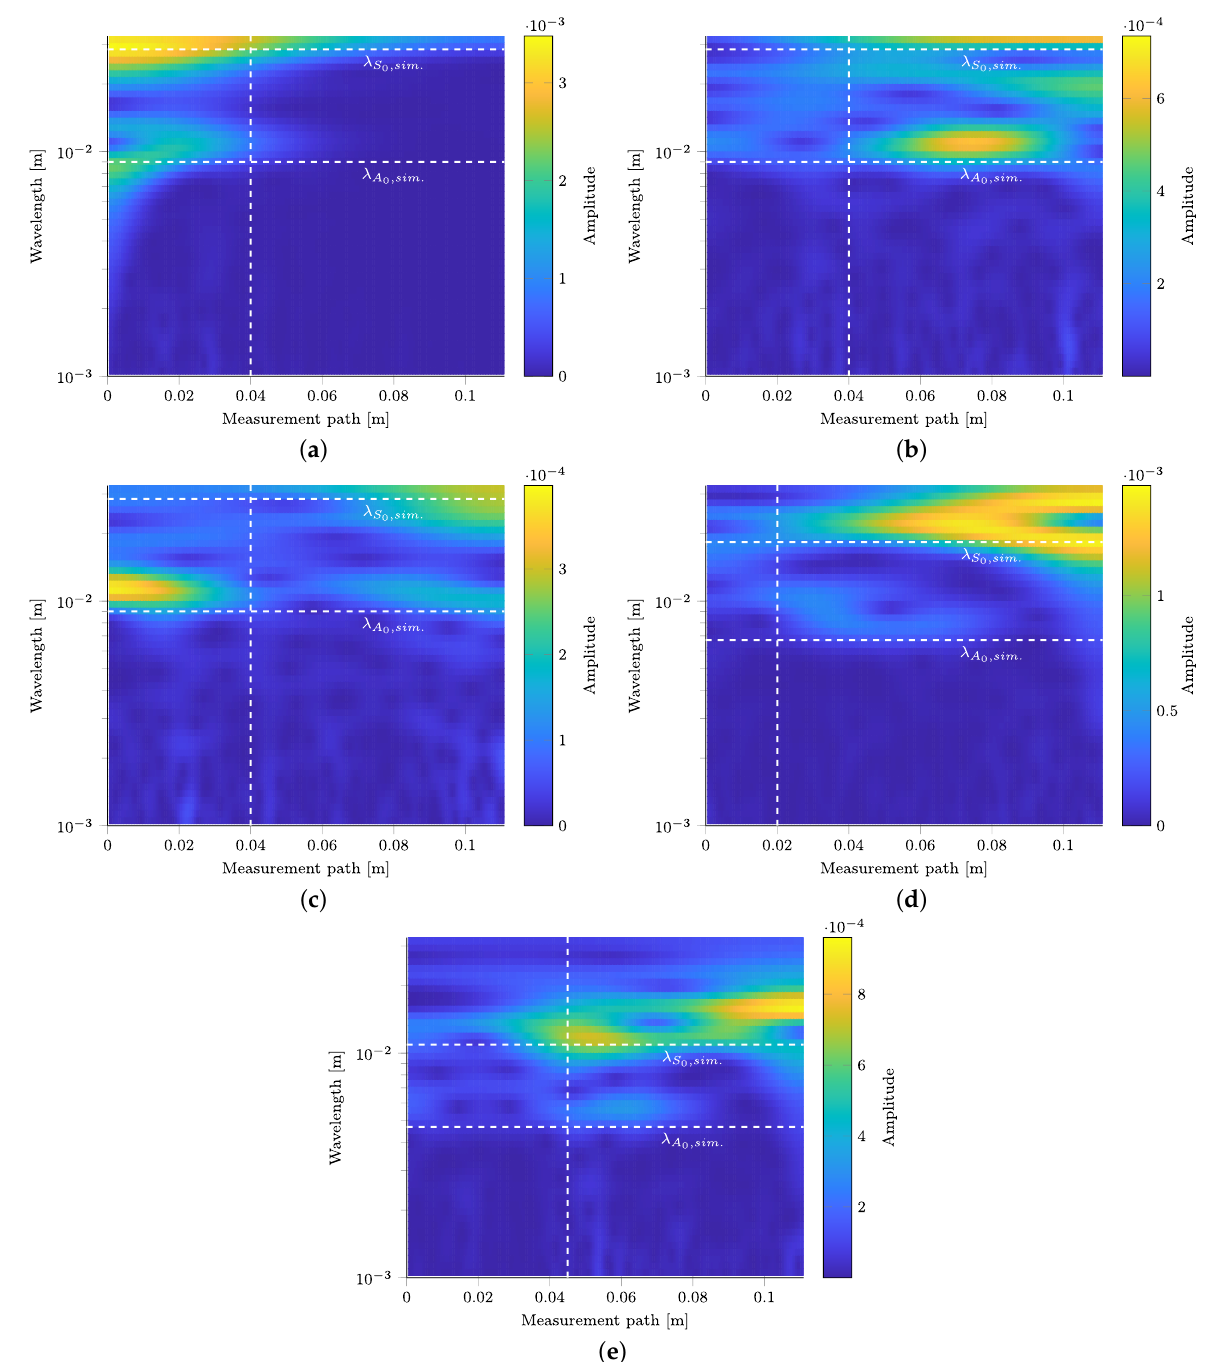
Figure 13. Spatial CWT of the 3D LDV measurements at time steps as stated in Table 5. Horizontal dashed lines indicate the wavelengths λ from the dispersion diagrams. Vertical dashed lines indicate locations of interest of identified wave packages in the B-scans. ( a ) 75kHz and 50µs (cf. Figure 12b). ( b ) 75kHz and 115µs (cf. Figure 12b). ( c ) 75kHz and 145µs (cf. Figure 12b). ( d ) 120kHz and 75µs (cf. Figure 11b). ( e ) 200kHz and 70µs (cf. Figure